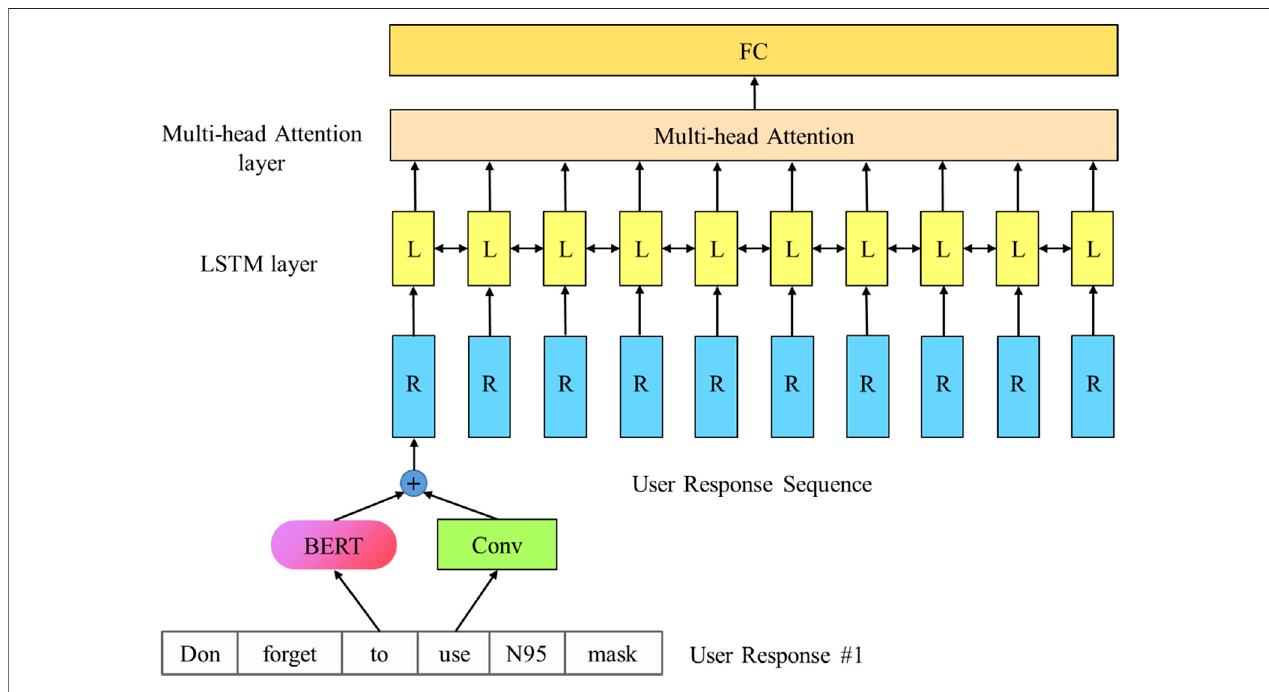
FIGURE 2 | The architecture of